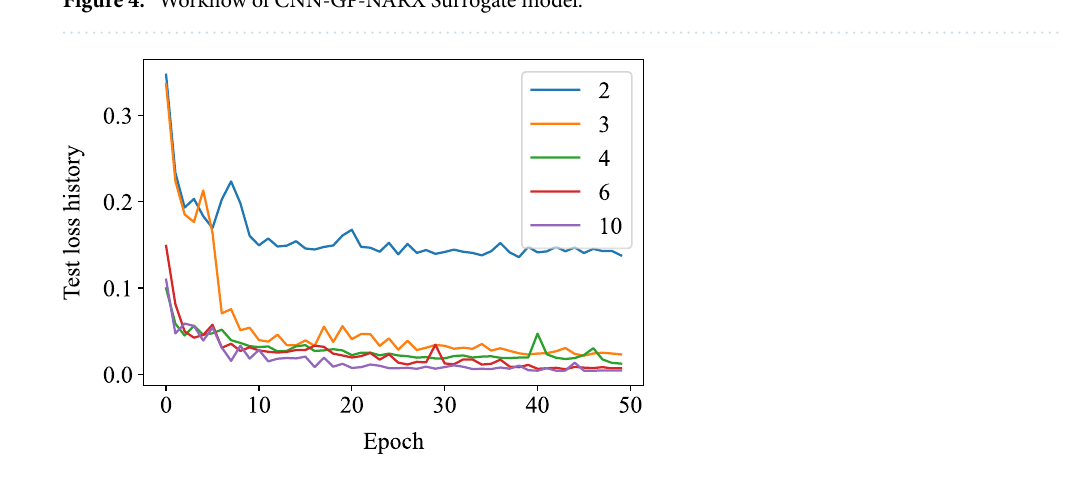
Figure 5. Test loss history of different numbers of